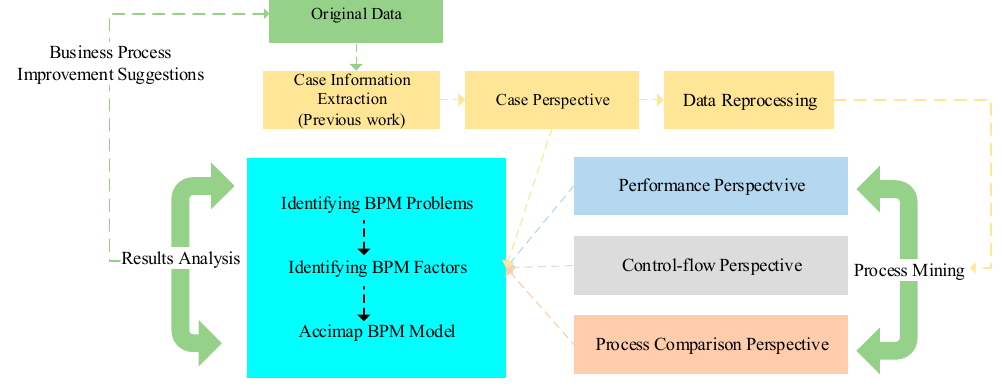
Figure 1. Methodology of this study.